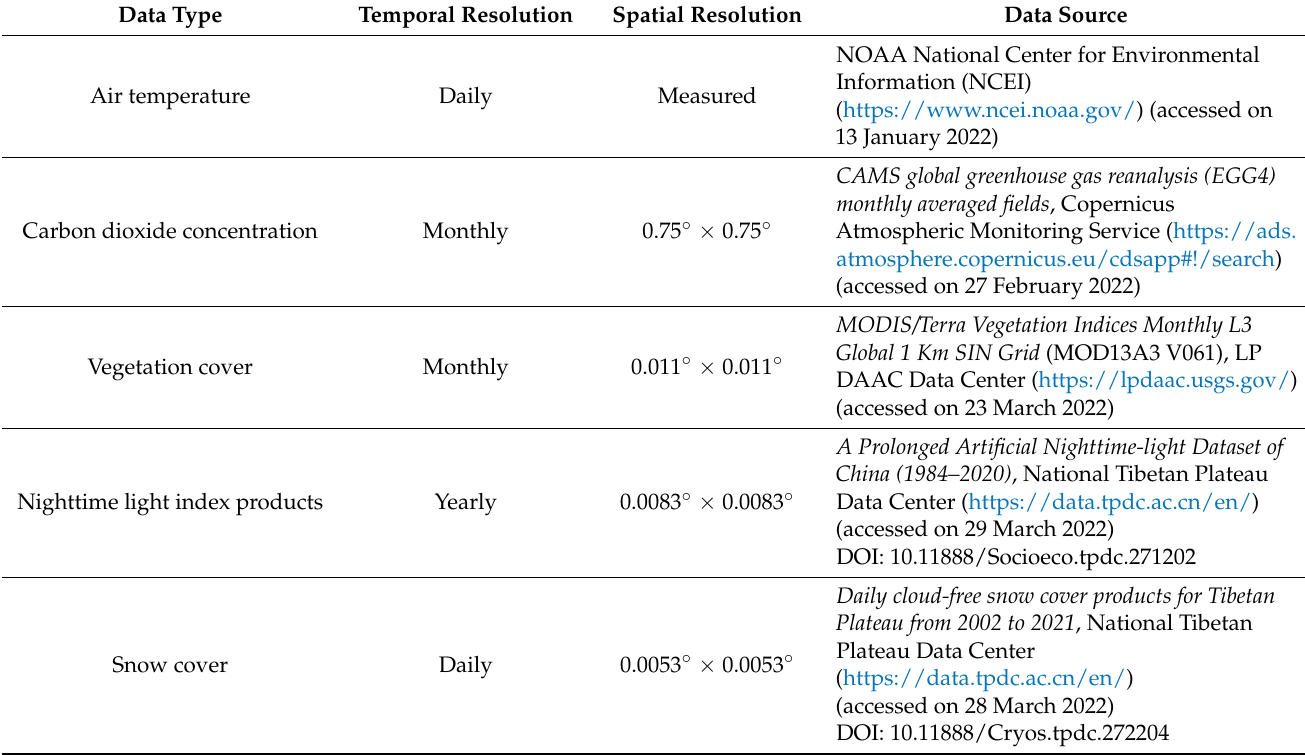
Table 1. Data acquisition for each data